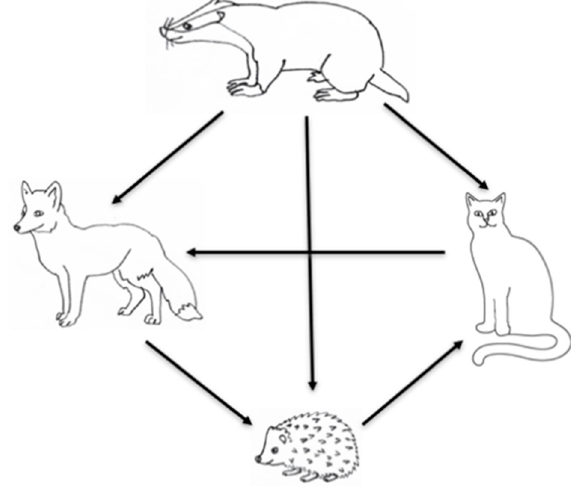
Figure 1. A diagrammatical representation of the hierarchical relationship in ‘winning’ access to food during paired dyads. The direction of the arrow shows the direction of the dominance is the species with the higher % of wins within dyads.